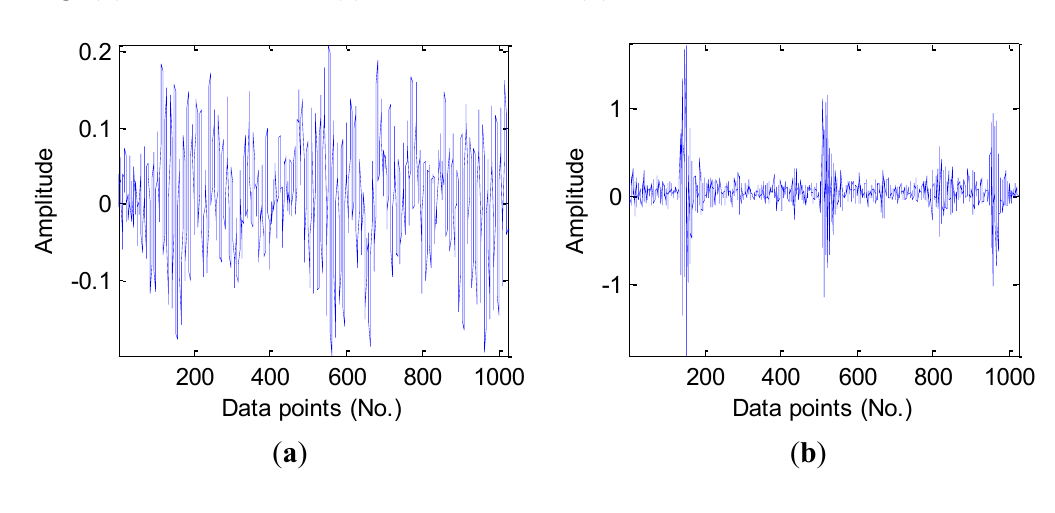
Figure 4. The vibration signal waveforms from the different fault types: ( a ) Health bearing. ( b ) Inner race fault. ( c ) Outer race fault. ( d ) Ball